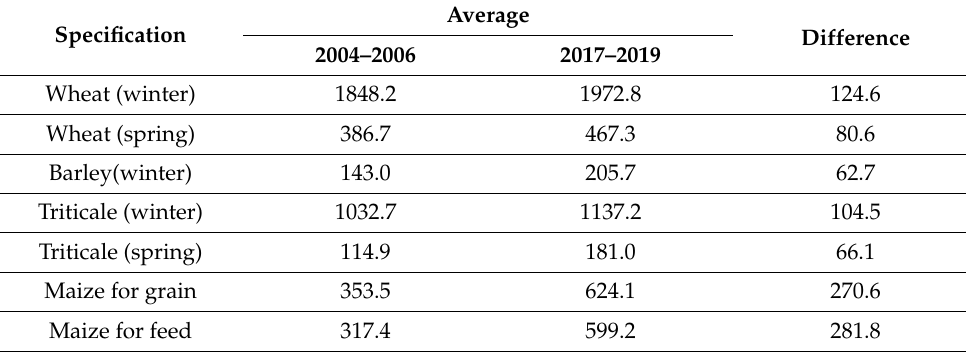
Table 5. Changes in the sown area of main crops in Poland in 2004–2019 (per thousand hectares).